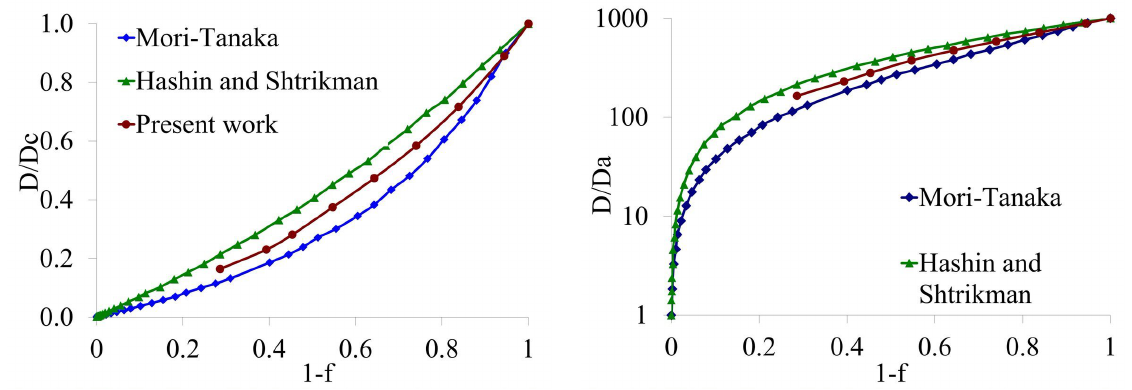
Fig. 6. Diffusivity coefficient of concrete ( D ) versus aggregate volume fraction (1- f